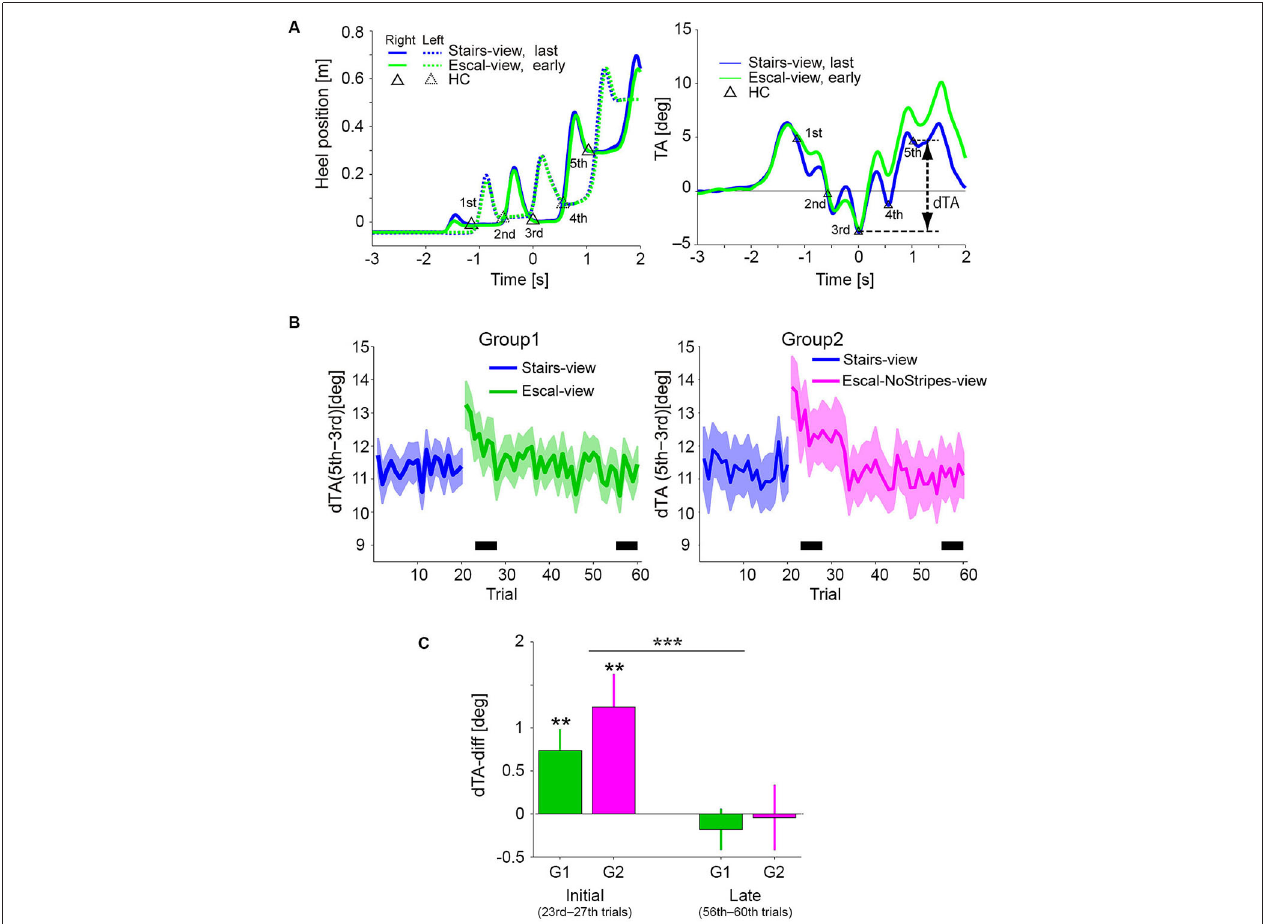
Colored area: SE. Left panel for Group 1 and right panel for Group 2). (C) Comparison between mean dTA-diffs (deviation of dTA from that in the Stairs-view condition) during the initial phase (23rd–27th) and late phase (56–60th), indicated by the thick horizontal bar in panel B , in both groups. Asterisks above the bar denote statistical significance of the dTA-diff from zero by t -test, and asterisks above the horizontal line denote statistical significance of the trial-phase (initial/late) factor, obtained by ANOVA. The error bar denotes SE and “**” p < 0.01, “***” p <